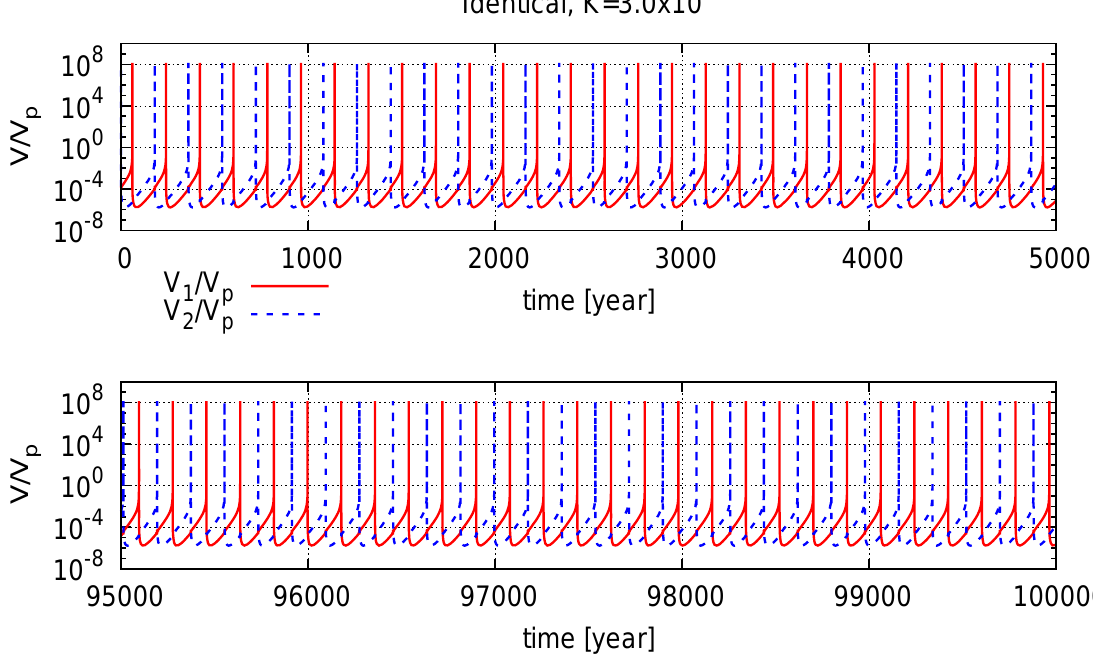
Fig. 5. The time evolution of V/V p for case 0 in a logarithmic scale. The variation from 5000 to 95000yr is not shown. The parameters are B = 2 . 20 × 10 5 Nm − 2 for both oscillators, and K = 3 × 10 3 Nm − 3 . The oscillators synchronize at a phase difference of ψ = − 3 . 14 (anti-phase).